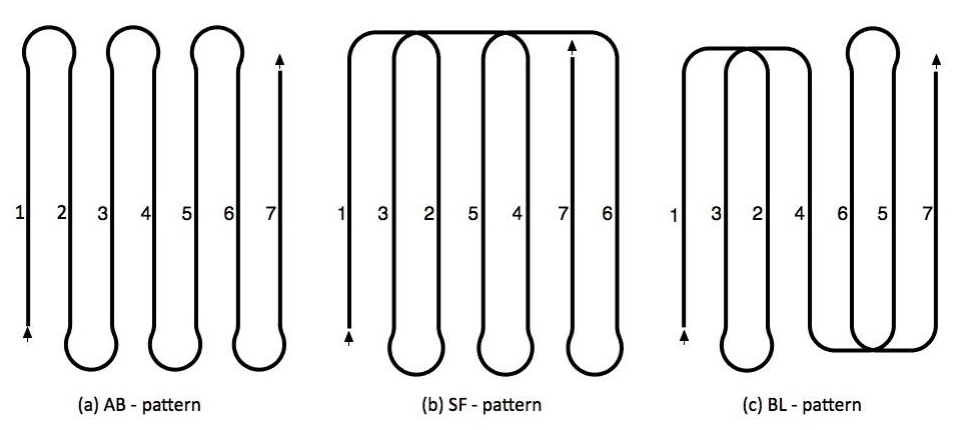
Figure 9. Three conventional fieldwork patterns, ( a ) AB—pattern, ( b ) SF—pattern and ( c ) BL—pattern used in the tests.